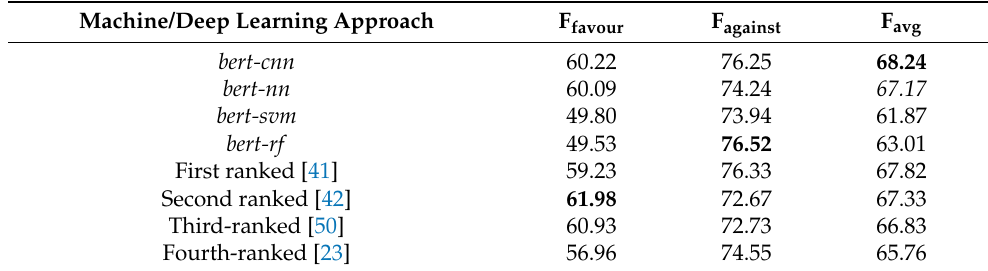
Table 7. Results obtained by proposed approaches and the top 4 submissions in the SemEval-2016